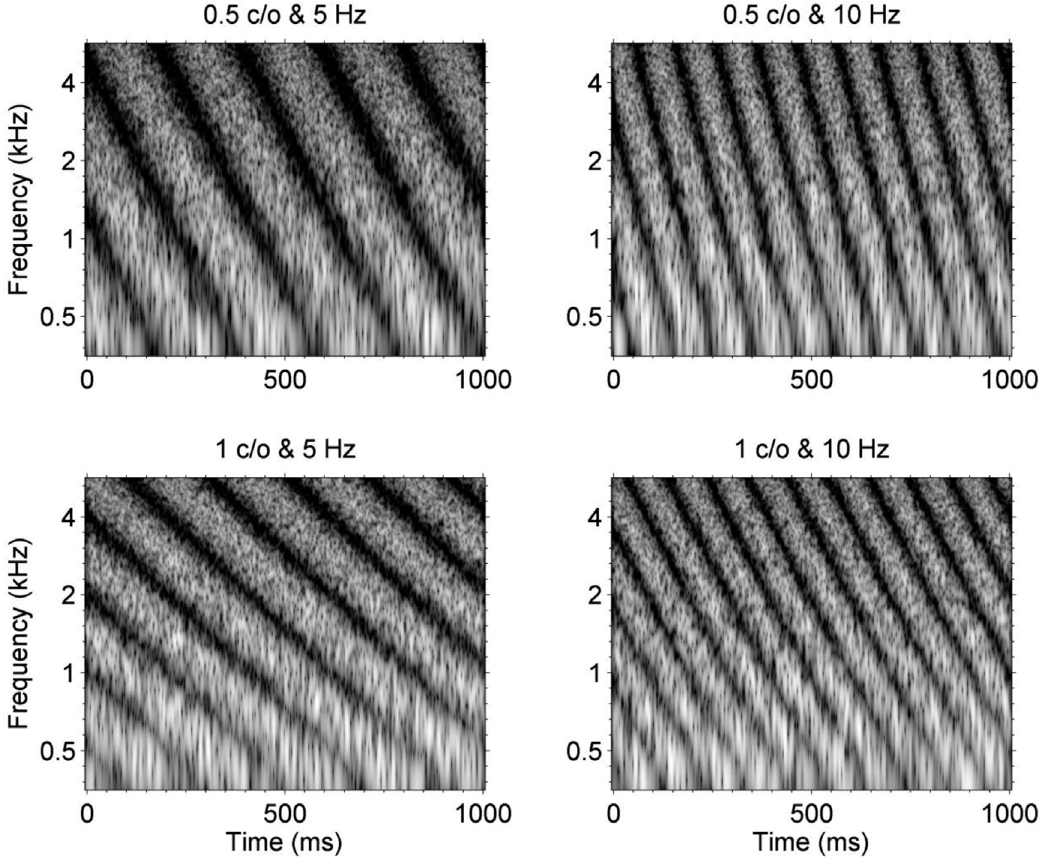
Fig 1. Example spectrograms for STM stimuli for four different combinations of spectral density and temporal rate. In these spectrograms, different amplitudes of the STM stimuli are depicted as a grayscale over a dynamic range of 40